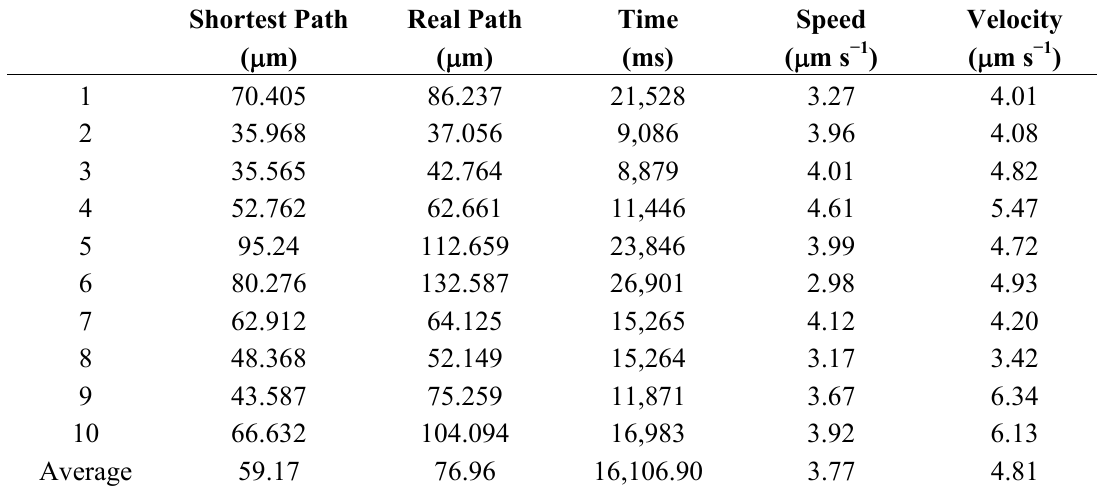
Table 5. Experiment data with time as control